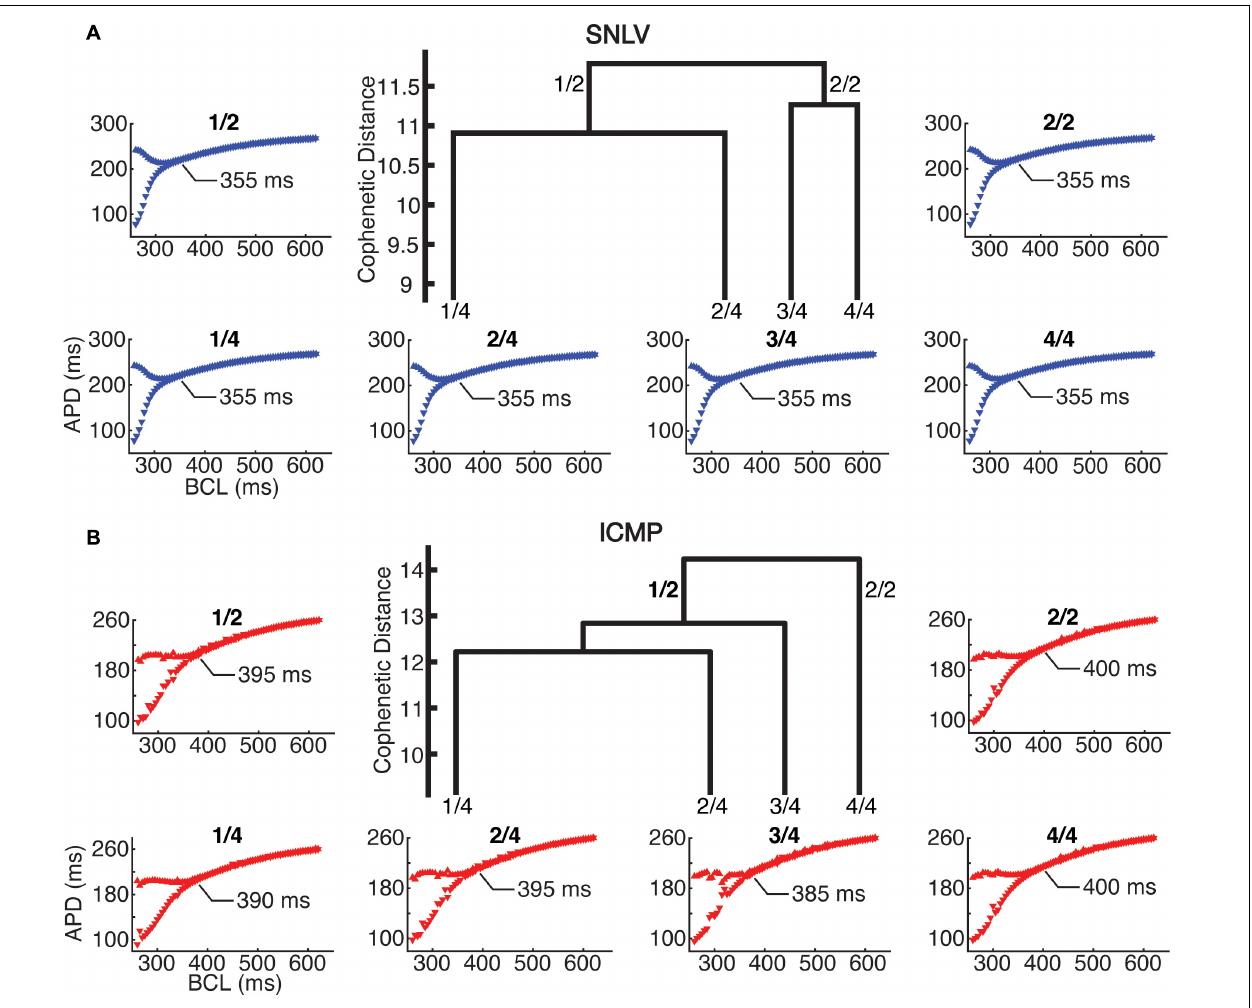
FIGURE 4 | Cell-level simulations in the 2 and 4 highest level clusters of (A) SNLV and (B) ICMP models. In the center of each sub-plot we show the four highest-level clusters of the dendrogram produced by AHC. The two highest-level clusters are noted as 2/1 and 2/2 and the four highest level clusters are noted as 4/1, 4/2, 4/3, and 4/4. Note that ICMP clusters 2/2 and 4/4 are identical since no bifurcation of the dendrogram occurs at this level. The bifurcation plots surrounding the dendrograms are labeled after the cluster that they have been created from ( X -axis is pacing cycle length in ms and Y -axis is APD in ms). For all clusters, onset of alternans occurred at ICMP models at longer cycle length intervals compared to SNLV models (385–400 ms vs 355